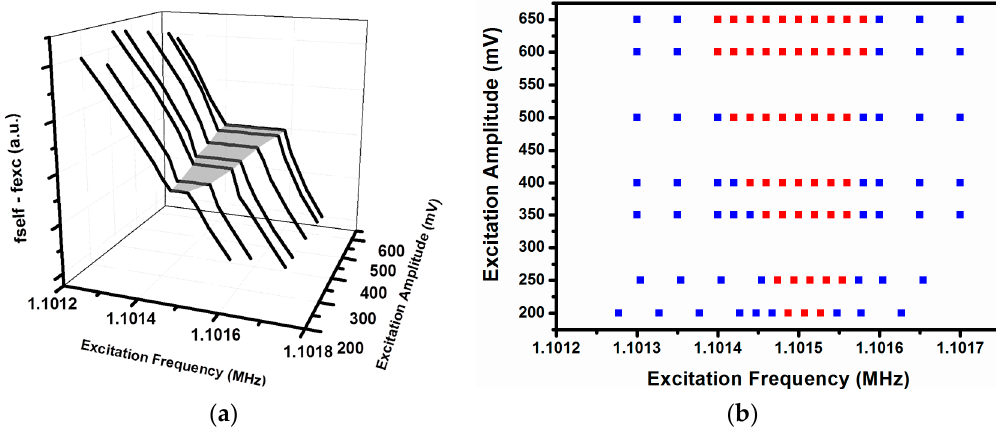
Figure 11. ( a ) The Arnold tongue, corresponding to excitation at the same frequency as the self-sustained (method ( b )). The shaded gray zone is the synchronized zone, which widens when the amplitude of excitation grows; ( b ) A 2D representation of the Arnold tongue, in which the red squares represent the minimum difference between self-oscillation frequency and excitation frequency.